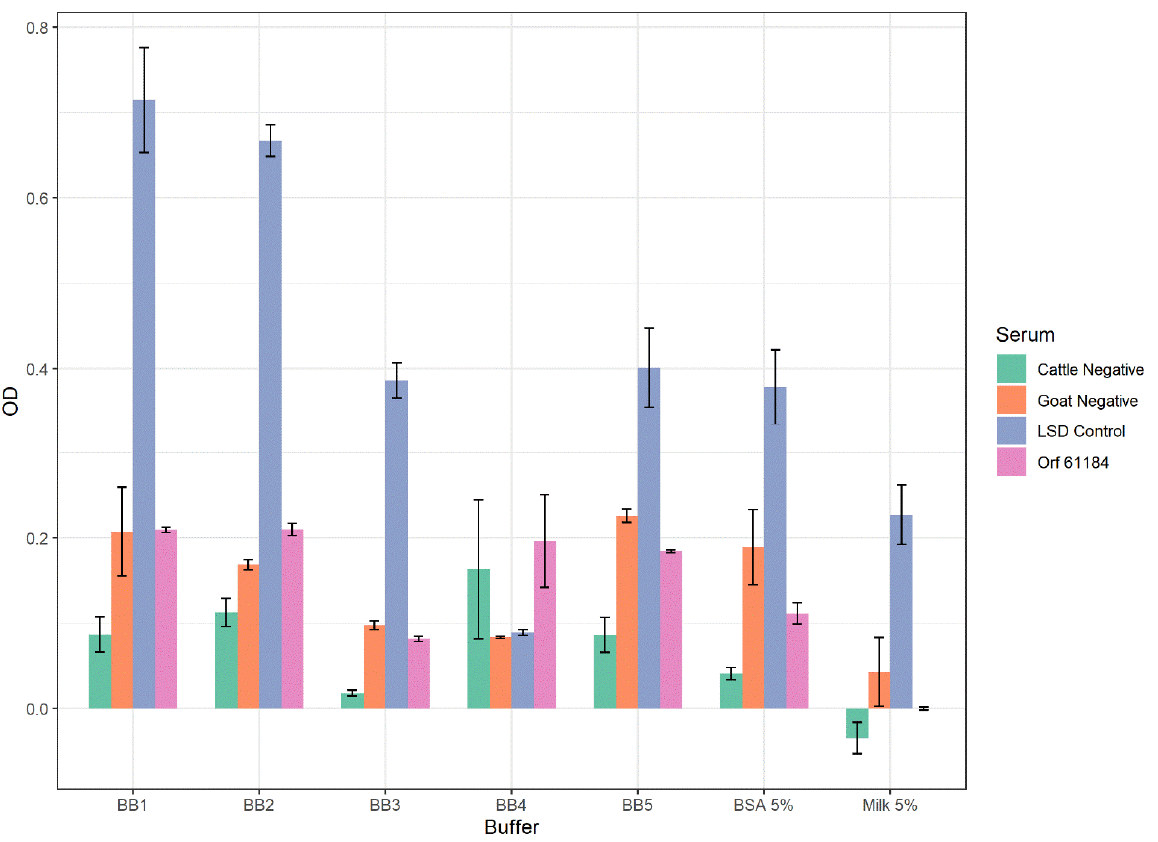
Figure 1. Comparative analysis of blocking buffers for the capripox iELISAs. Protein ‐ based (5% milk and 5% BSA) and protein ‐ free (BB1, BB2, BB3, BB4, and BB5) blocking buffer formulations were tested for the capripox iELISAs blocking, sera, and secondary antibody dilutions of LSD ‐ positive and LSD ‐ negative sera. While milk and BSA had low signals, BB1 produced low background and the highest positive signal. Data are presented as average of two runs in duplicate ± standard devi ‐ ation.